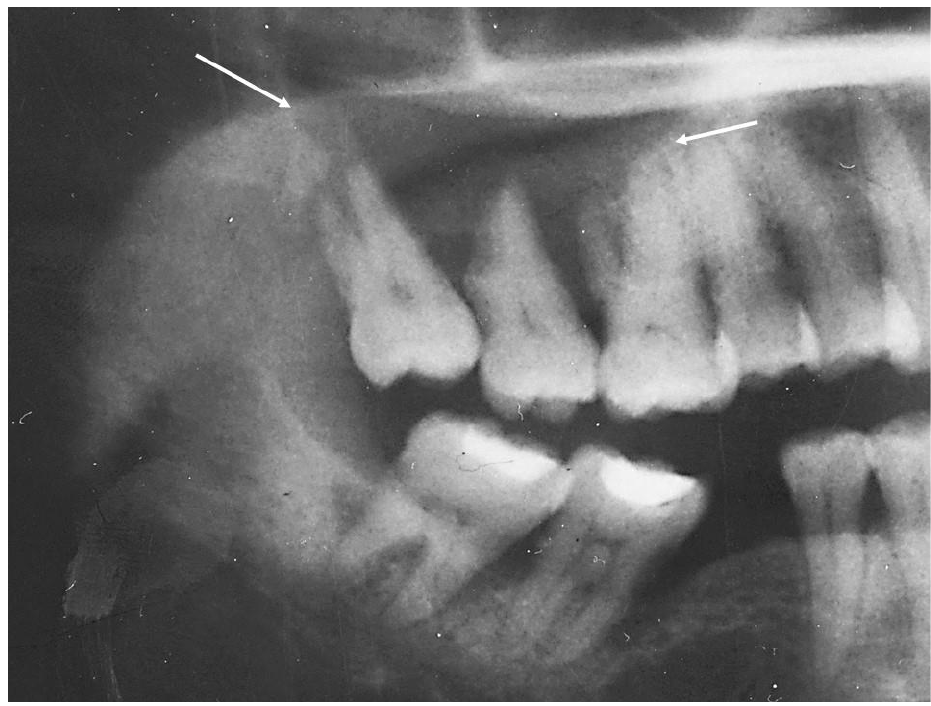
Figure 1. Panoramic X-ray film revealing poorly demarcated radiolucency in the right posterior maxilla.